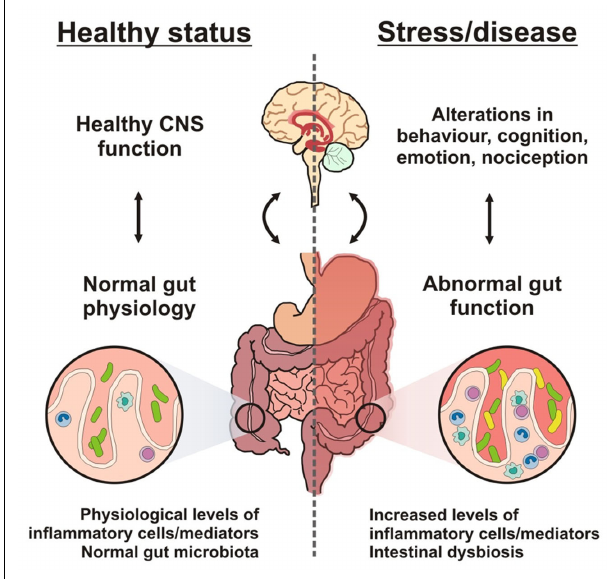
FIGURE 4 | Brain–gut–microbe communication in health and disease. A stable gut microbiota is essential for normal gut physiology and contributes to appropriate signaling along the brain–gut axis and to the healthy status of the individual as shown on the left hand side of the diagram. Conversely, as shown on the right hand side of the diagram, intestinal dysbiosis can adversely influence gut physiology leading to inappropriate brain–gut axis signaling and associated consequences for CNS functions and disease states. Stress at the level of the CNS can also impact on gut function and lead to perturbations of the